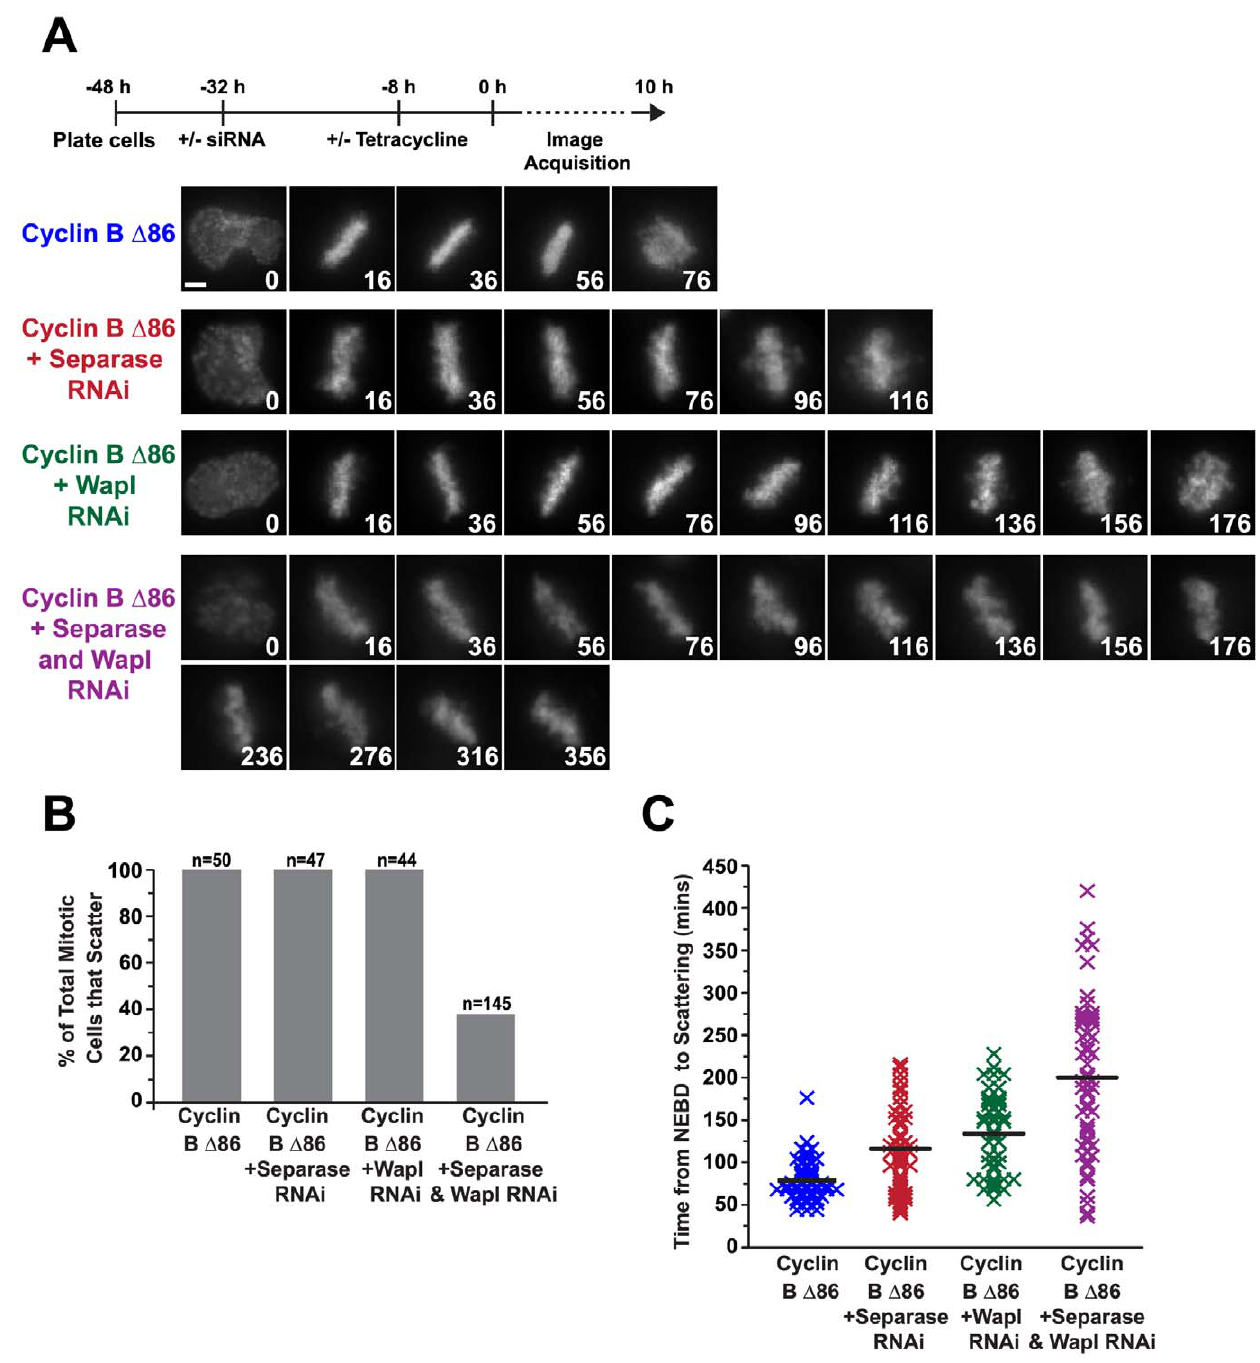
Figure 6. Chromosome scattering is prevented by inhibition of the two pathways that remove cohesion. ( A ) Selected images from time-lapse imaging sequences of Cyclin B D 86 HeLa FRT cells expressing histone H2b:mRFP and subjected to the indicated perturbations. The experimental scheme is depicted on top. Time (in mins) is indicated on the lower right of each panel; time 0 is NEBD. Scale bar, 5 m m. ( B and C ) Quantification of the experiments in (A); (B) the percentage of total cells in mitosis that scatter for each condition and (C) the time that those cells remain in mitosis before scattering is plotted (only cells that scattered were analyzed for the double separase/Wapl inhibition); each mark represents one cell and the black line indicates the average.